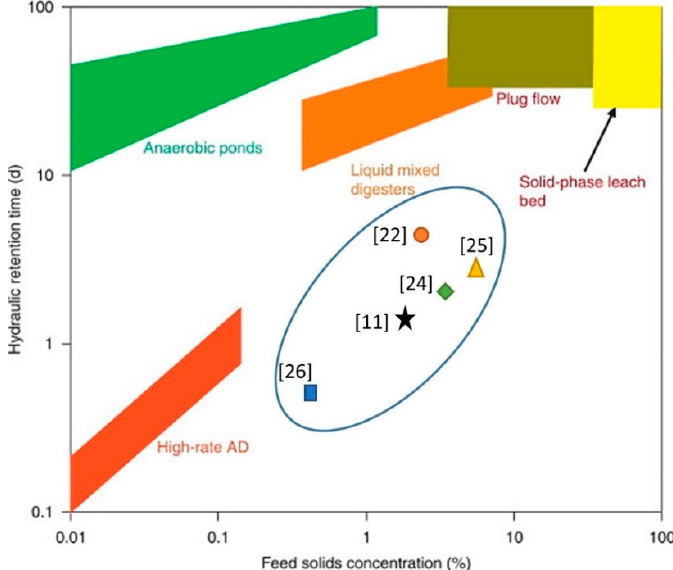
Figure 2. Hydraulic retention time for various anaerobic digestion (AD) reactors depending on feed solids content (Adapted from Batstone and Jensen [28]) where data from [11,23,25–27] are